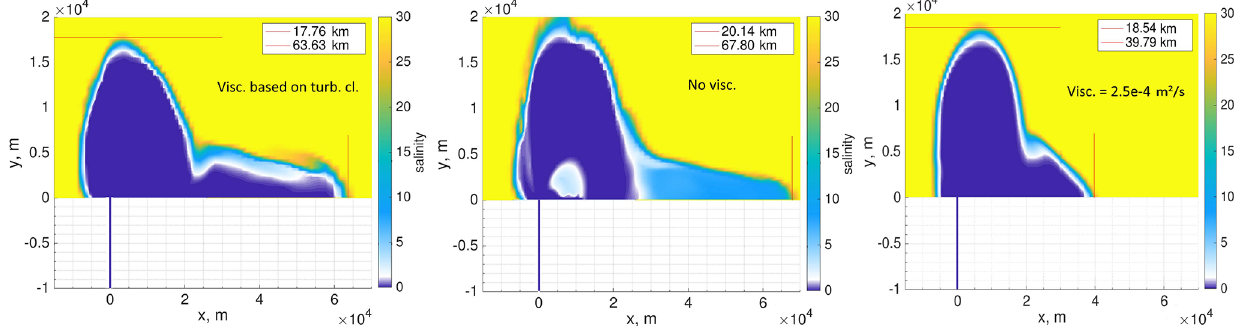
Geosci. Model Dev., 14, 6945–6975, 2021